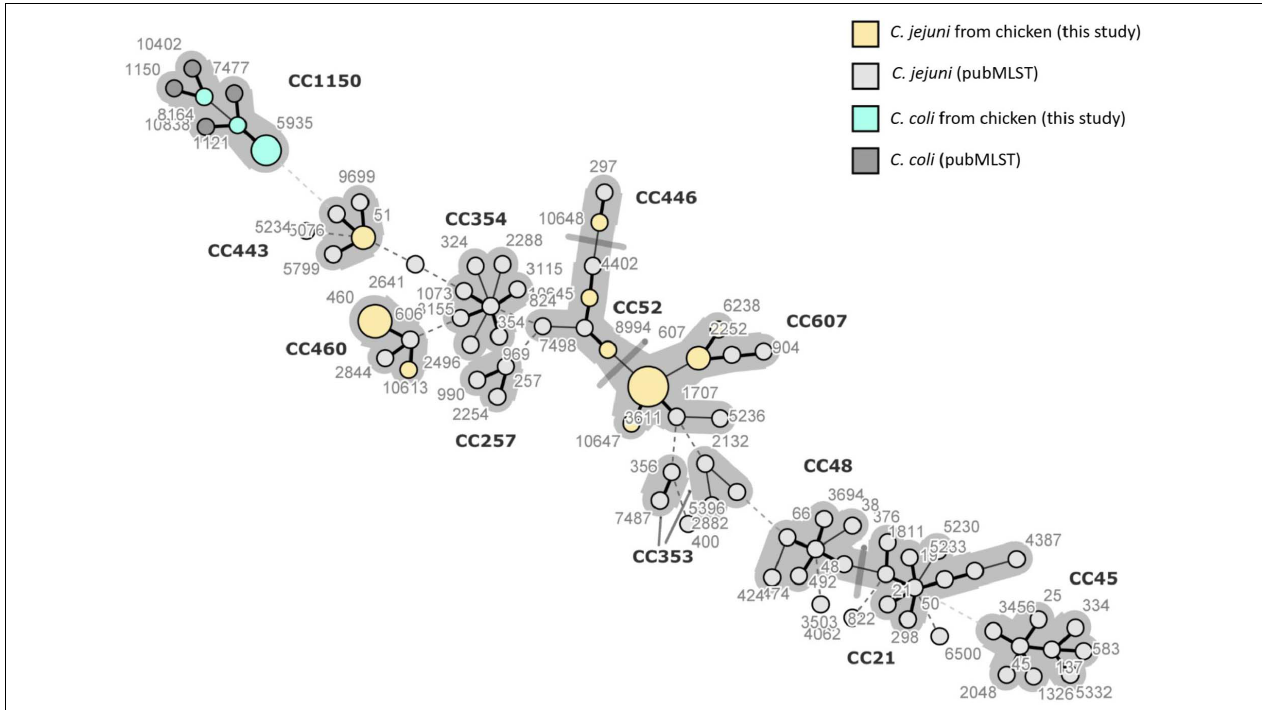
FIGURE 4 | Minimum spanning tree of Campylobacter jejuni and Campylobacter coli sequence types (STs) created from multilocus sequence typing allelic profiles. Each ST is represented as a circle, with the size of the circle proportional to the number of isolates of that ST for the isolates obtained in this study (STs colored in yellow and green). The figure also includes STs commonly reported in Korea and elsewhere from poultry and humans which were retrieved from pubMLST. The branch length and thickness represent the allelic distance: a thick short line connects single-locus variants, a thin longer line connects double-locus variants, and a dashed line connects STs separated by three or more allelic differences. Background shading highlights clonal complexes at a distance of two alleles in this